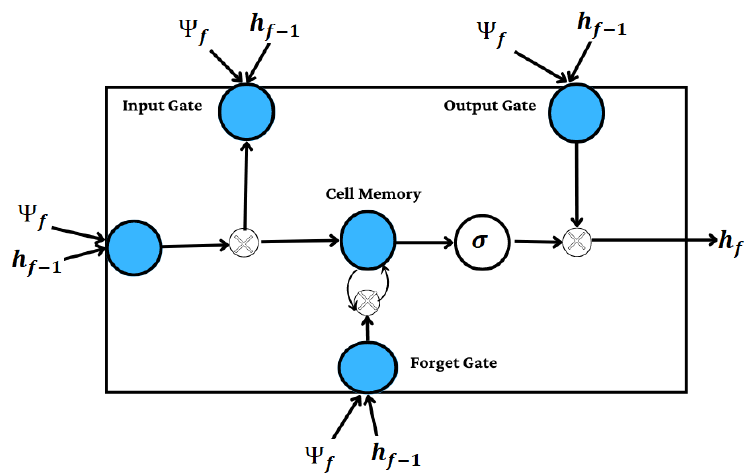
Figure 2. LSTM cell structure in RNN degradation network. Where Ψ f , and h f − 1 are the input layer state at current time step f , and hidden layer state at past time step f − 1. U f , f f , c f , o f and h f are input, forget, memory cell, and output